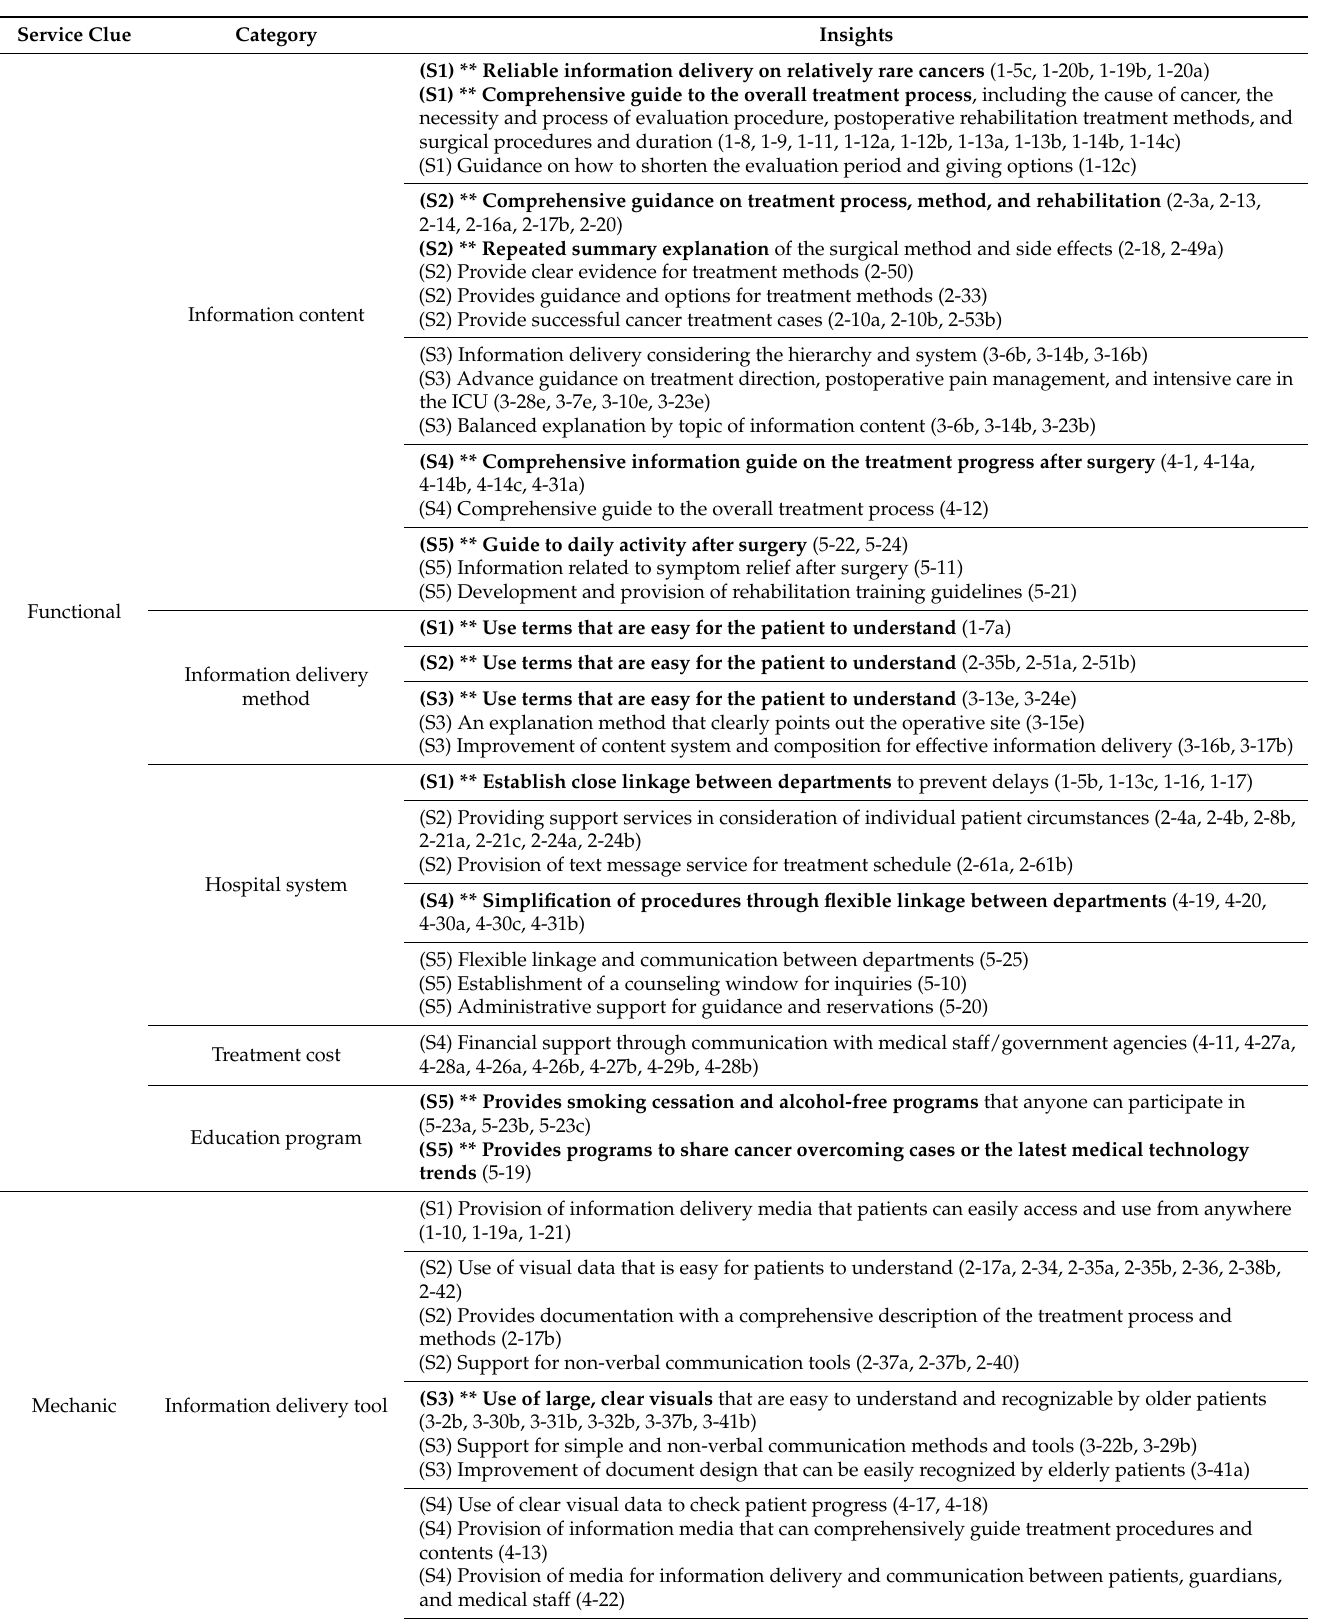
Table A2. Summary of insights based on the HNC patient